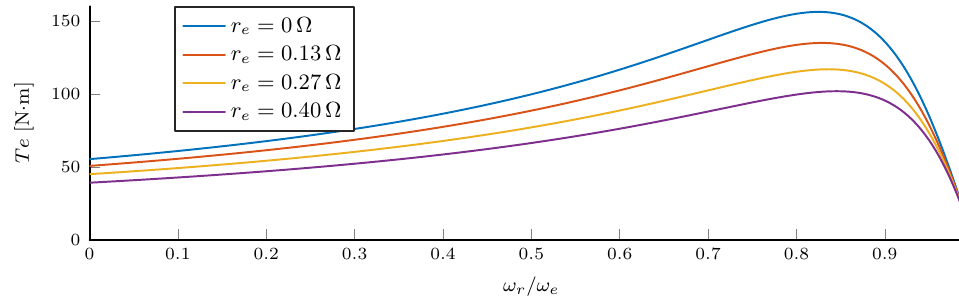
Figure 10. Steady-state torque vs. speed for different values of external stator resistance.